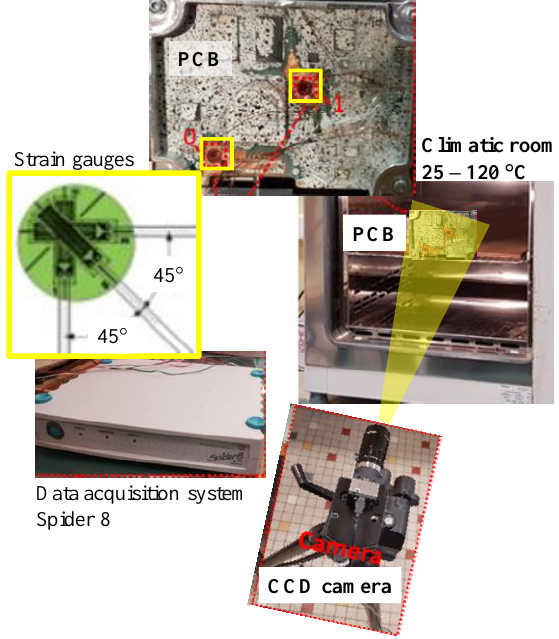
Figure 3. The experimental setup for DIC measurements.